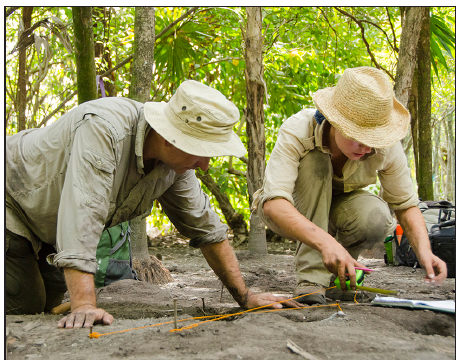
Figure 2: Phil and Cesca excavating a land crab ( Cardisoma guanhumi ) burrow (Photo Mark